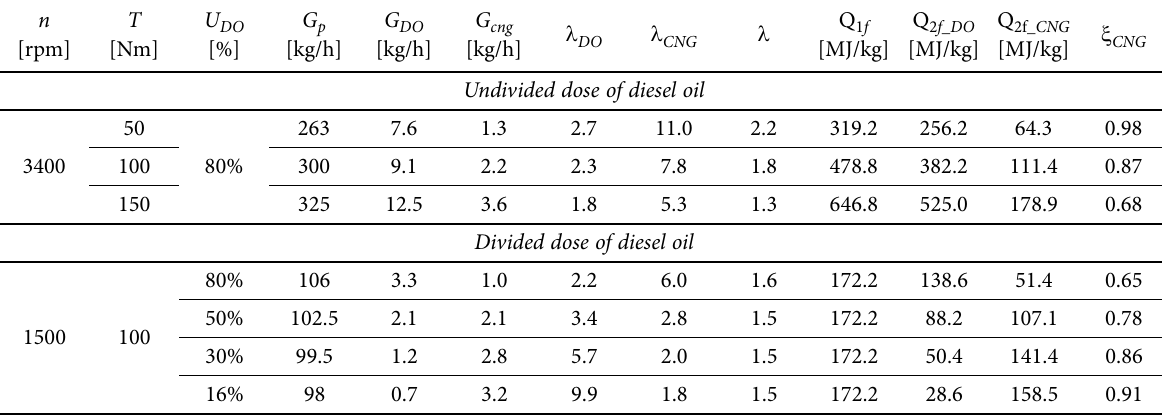
Table 3. Parameters which characterise the charge in the combustion chamber for selected measurement